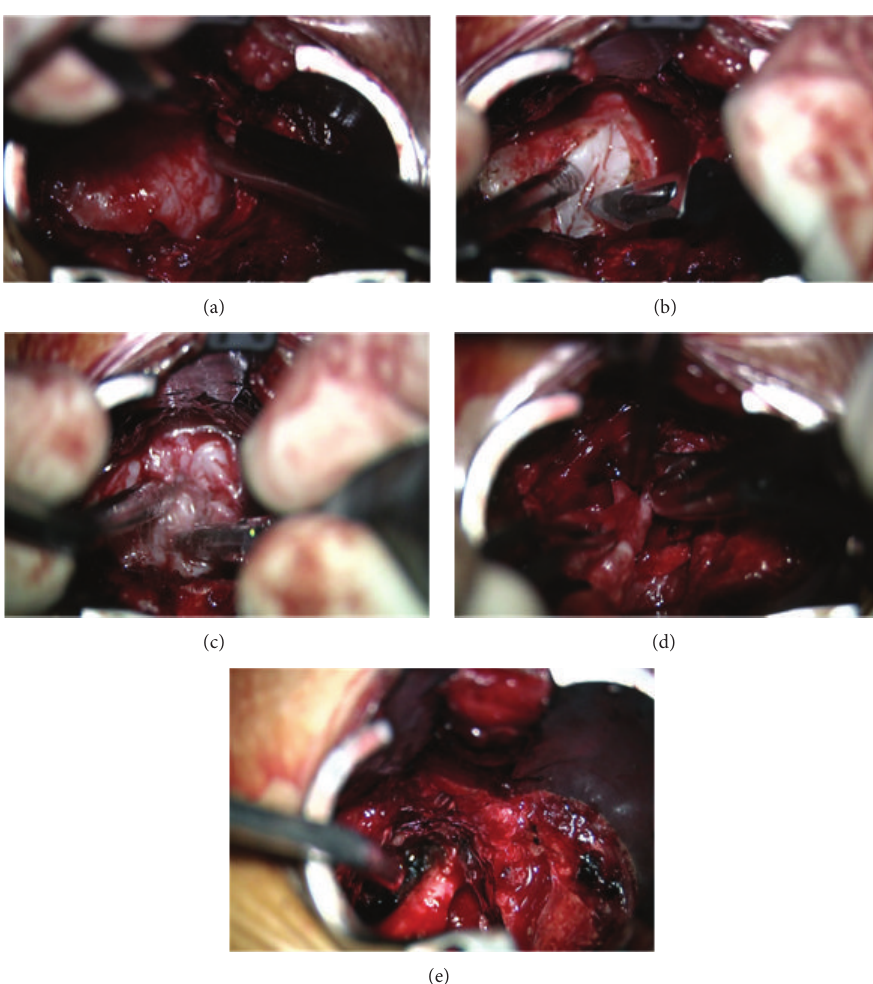
Figure 6: Intraoperative microsurgical images showing (a) bone removal allowing tumor exposition; (b) tumor capsule incision; (c) internal debulking with CUSA; (d) piecemeal tumor removal; (e) L3 nerve root preservation after tumor gross total resection.